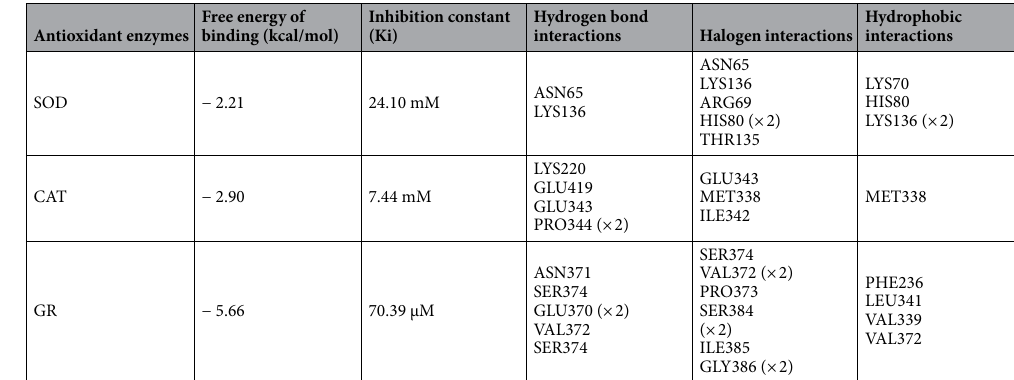
Table 6. Molecular interactions of Penoxsulam with antioxidant enzymes. SOD Superoxide dismutase, CAT Catalase and GR : Glutathione reductase. Aminoacids; ARG Arginine, ASN Asparagine, GLU Glutamic acid, GLY Glycine, HIS Histidine, ILE Isoleucine, LYS Lysine, MET Methionine, PHE Phenylalanine, PRO Proline, SER Serine, THR Threonine, VAL Valine.